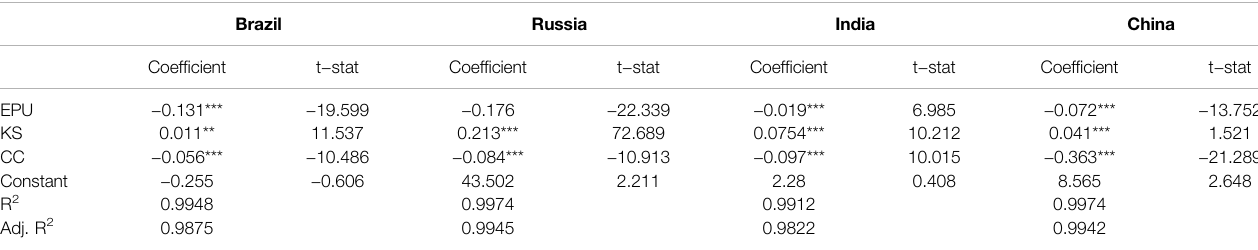
TABLE 9 | Results of robustness with dynamic ordinary least square (OLS).